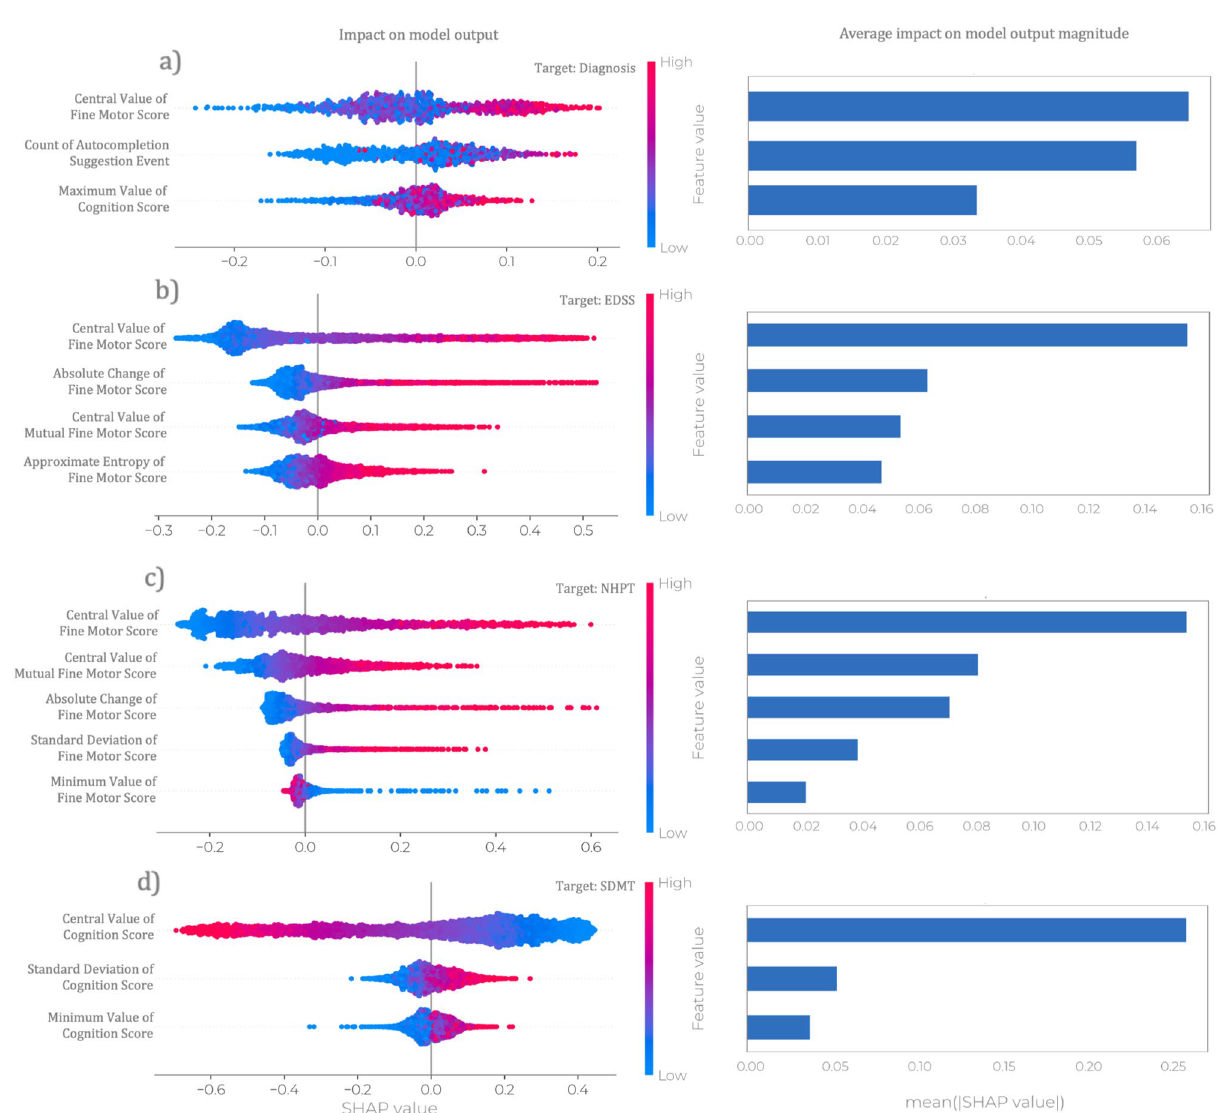
Figure 6. Model Interpretation using SHapley Additive exPlanations (SHAP). The left column provides the summary plots relative to the impact of features on the model prediction. Each point on the summary plot denotes a Shapley value for a given feature and an instance, while the colour represents the value of the feature from low to high. Overlapping points are jittered in y-axis direction to provide insight into the distribution of the Shapley values per feature. The right column provides the global importance of each predictor, which is achieved by averaging the absolute Shapley values per feature across the daily